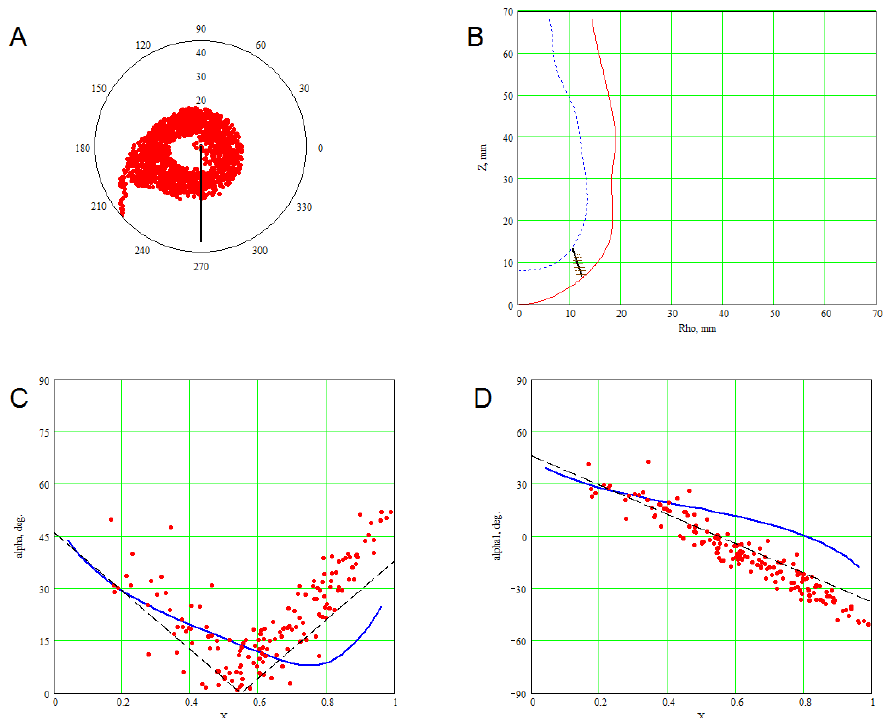
Figure 12. Fiber angles in the model and experimental data. The IVS in the apical area ( ψ = 65 ◦ ) is shown. The conventional signs are the same as in Figure